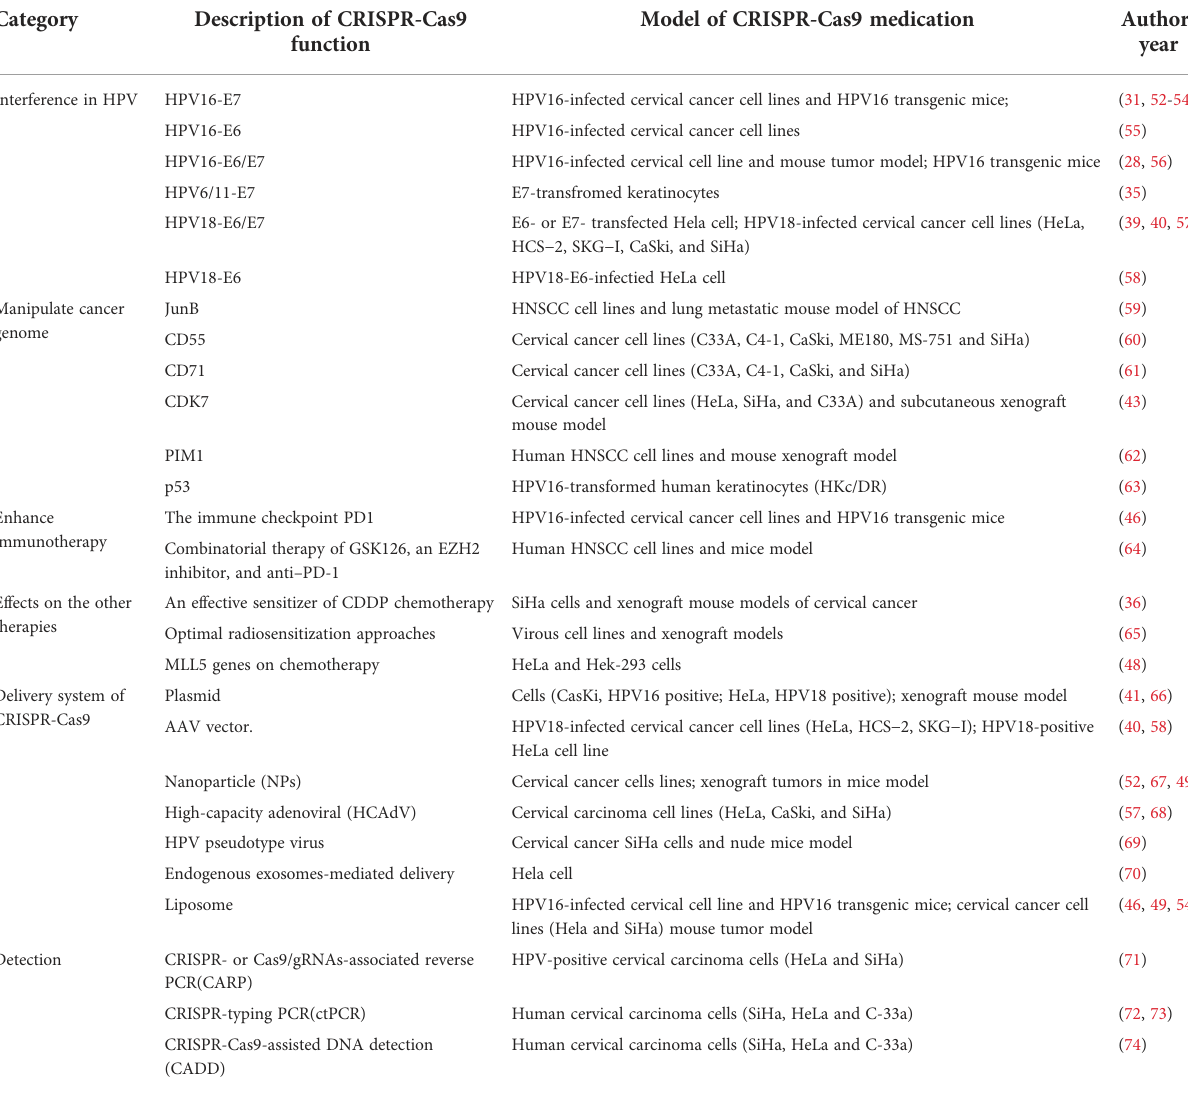
TABLE 2 Summary of application of CRISPR-Cas9 in HPV-driven